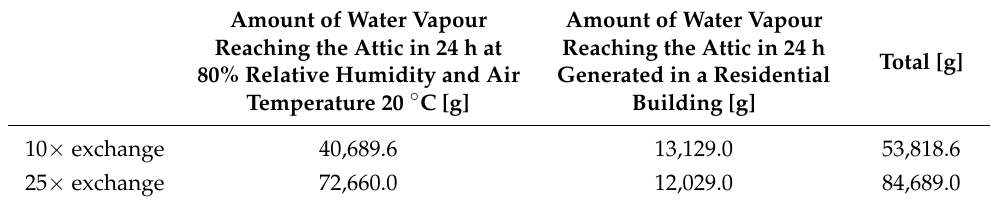
Table 3. Total amount of water vapour reaching the attic depending on the adopted air exchange [58]. Amount of Water Vapour Amount of Water Vapour Reaching the Attic in 24 h Reaching the Attic in 24 h at 80% Relative Humidity and Air Temperature 20 ◦ C [g]